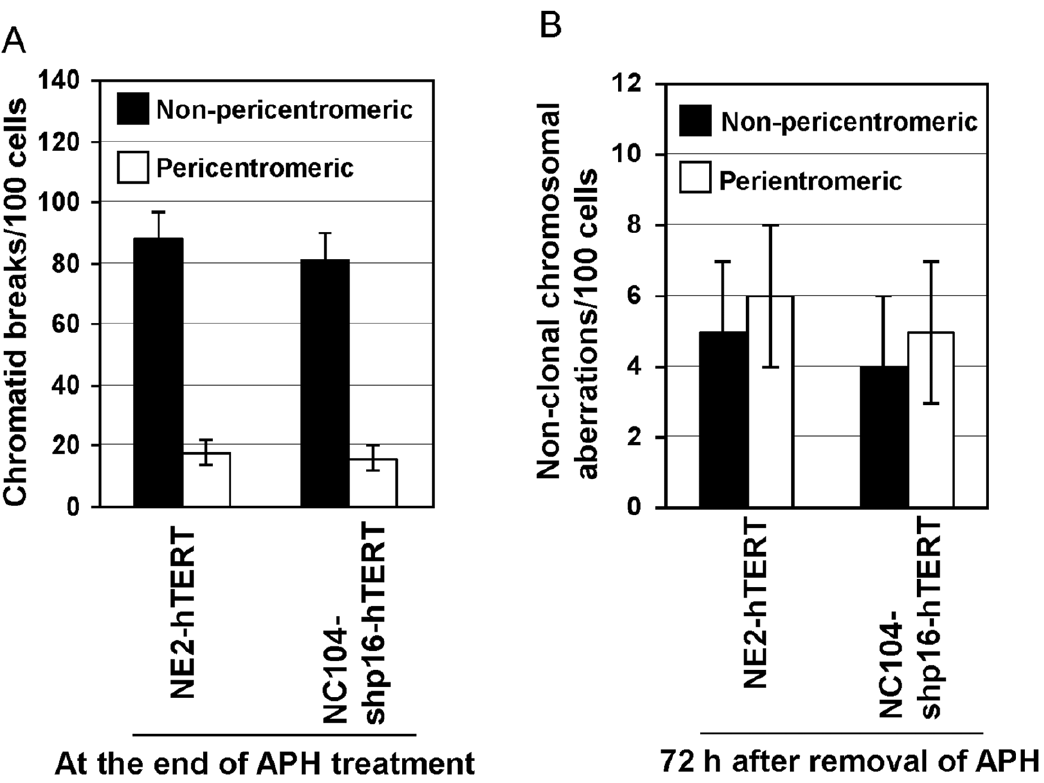
Figure 4. Chromosome aberrations after APH treatment in hTERT-immortalized cell lines without expression of HPV16 E6E7. A: Frequencies of chromatid breaks measured at the end of APH treatment. B: Frequencies of non-clonal chromosomal aberrations measured at 72 h after removal of APH.